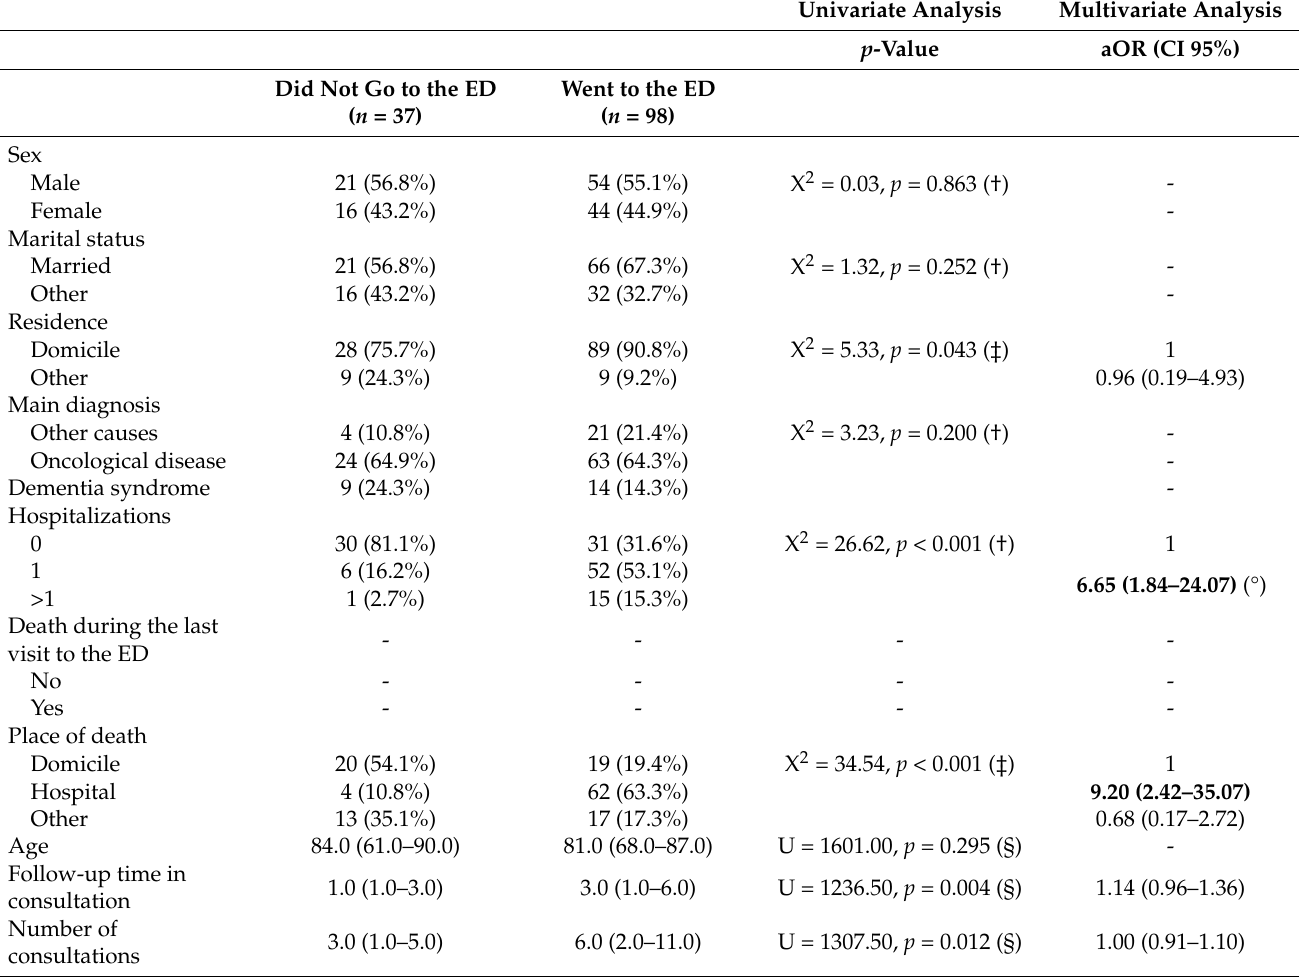
Table 2. Associations with admissions to the emergency